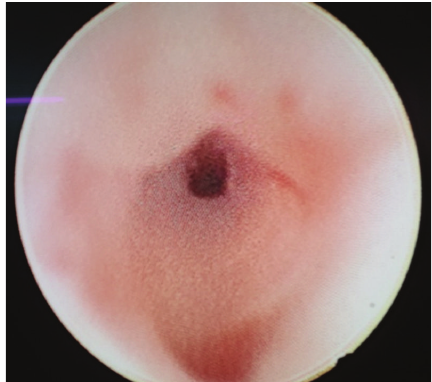
Figure 3: Urethroscopy showed narrowing in distal bulbar